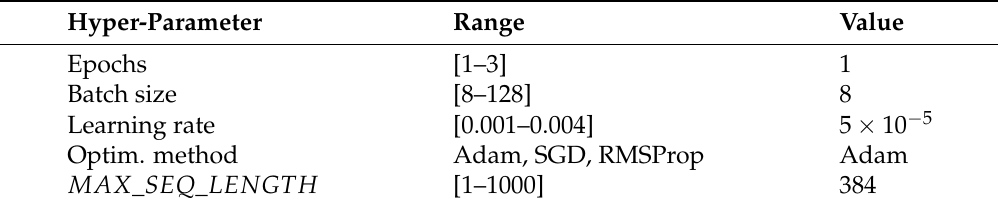
Table 3. Experimental model